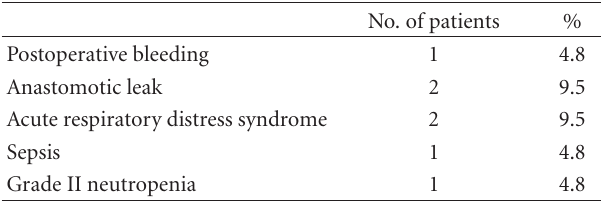
Table 1: Patients’ general characteristics. Table 2: Postoperative